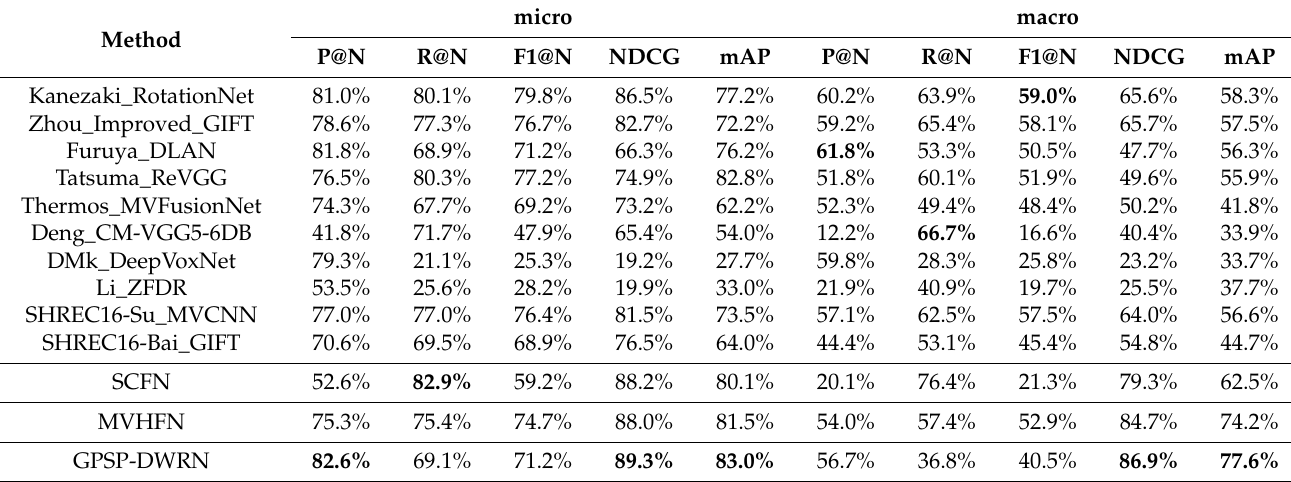
Table 5. Retrieval performance—SHAPENETCORE55. Bolding shows the maximum value in each column.